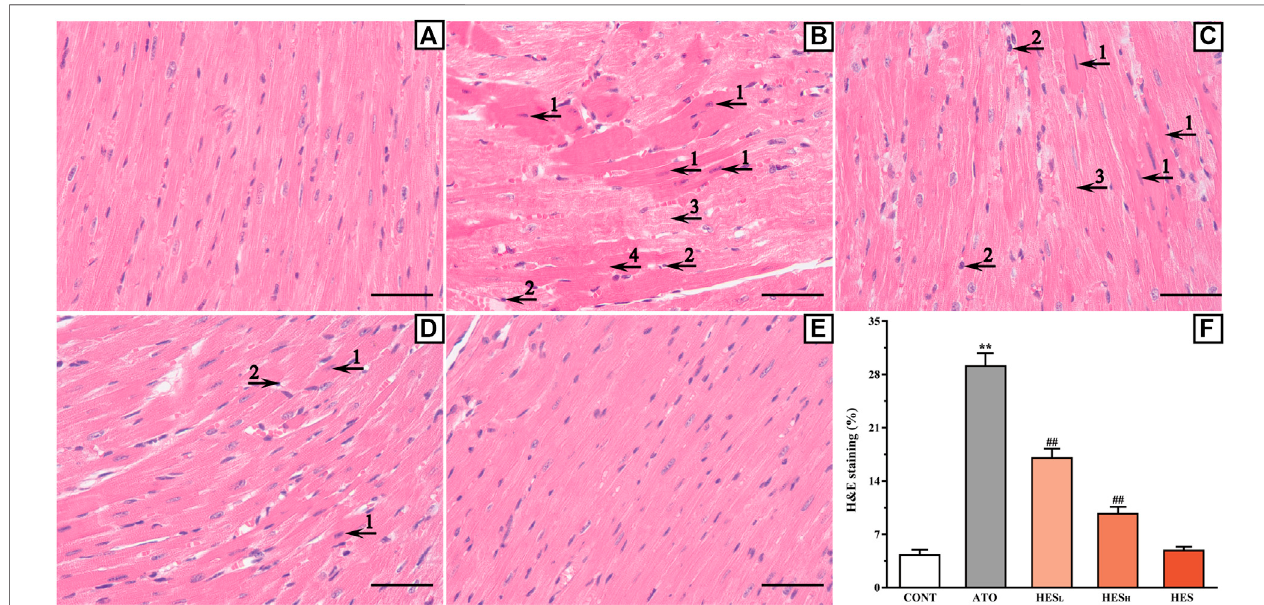
FIGURE 2 | Histopathological changes of heart between ATO group and HES treatment groups (scale bar (cid:1) 50 μ m, magni fi cation: × 400). The results of H&E stainingshownintheAtoErepresenttheCONT,ATO,HES